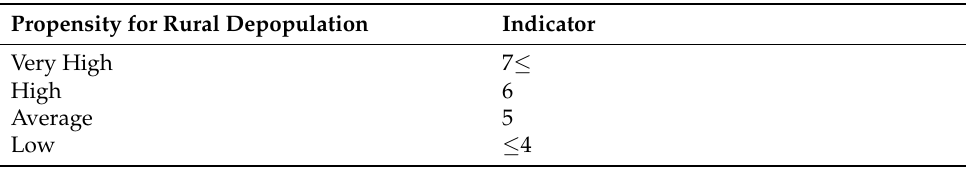
Table 2. Propensity for rural depopulation. Propensity for Rural Depopulation Indicator Very High 7 ≤